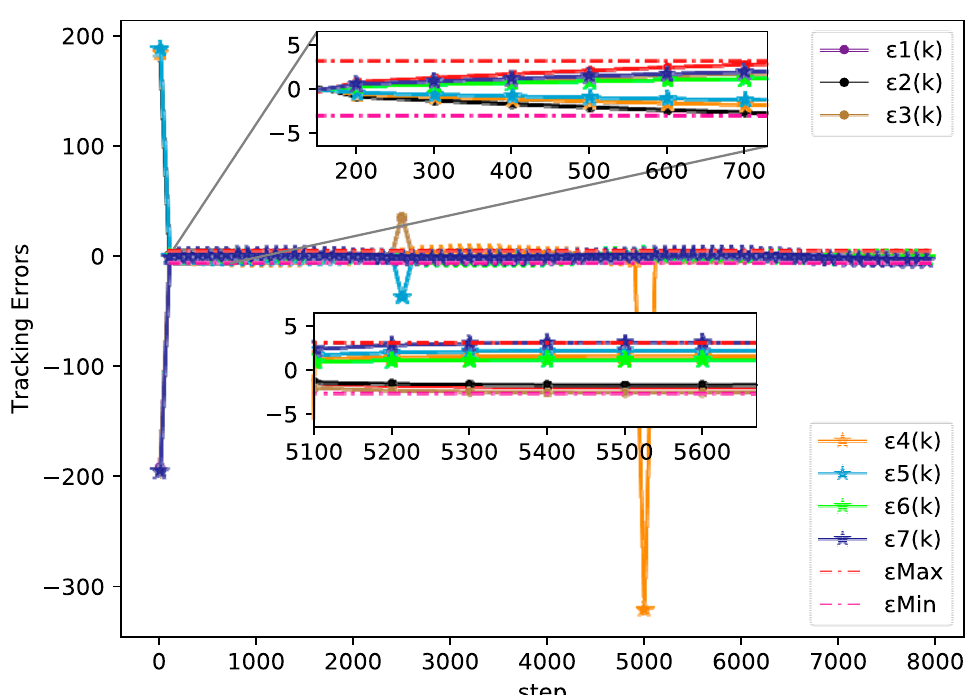
Figure 6. Tracking errors of each agent (example 2).